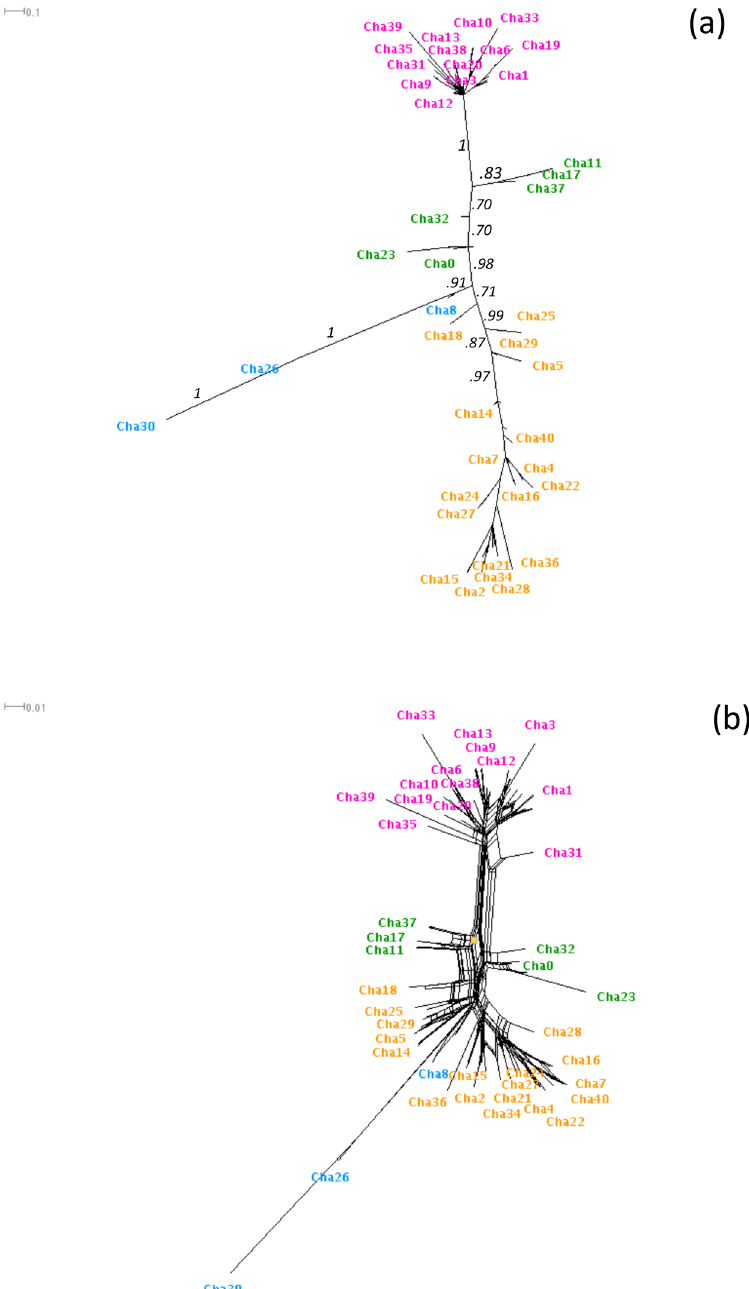
Figure 7. Phylogenetic relationships of exon 2 DAB variants according to ( a ) Bayesian inference and ( b ) Neighbor-Net network. Tips correspond to the 92 variants recorded but only the names of the 41 corresponding clusters are reported (Cha0 to Cha40). Posterior probabilities are reported on the branches. Different colours correspond to the four identified clades: purple, clade 1; green, clade 2; orange, clade 3; blue, clade